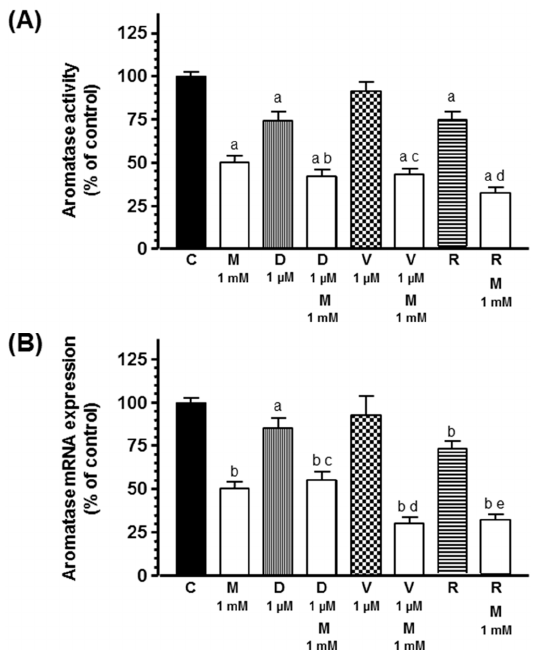
Figure 7. E ff ects of melatonin on docetaxel-, vinorelbine-, and radiation-induced changes on ( A ) aromatase activity and ( B ) aromatase mRNA expression. Data are expressed as the percentage of control group (mean ± SEM). a, p < 0.05 vs. C; b, p < 0.001 vs. C; c, p < 0.001 vs. D (1 µ M); d, p < 0.01 vs. V (1 µ M); e, p < 0.001 vs. R. C: control, M: melatonin, D: docetaxel, V: vinorelbine, R: radiation.